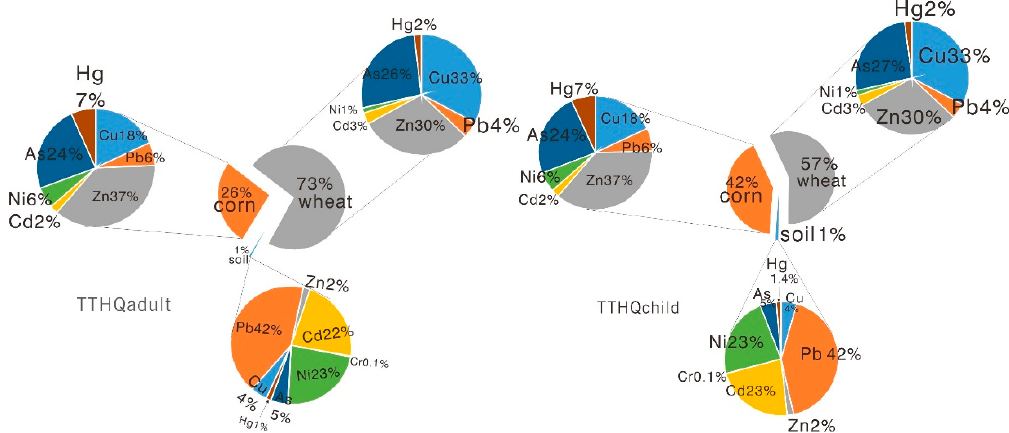
Figure 6. Contribution of metal(loid)s in three mediums (soil, wheat, and corn) to the total health risk for adults and children.